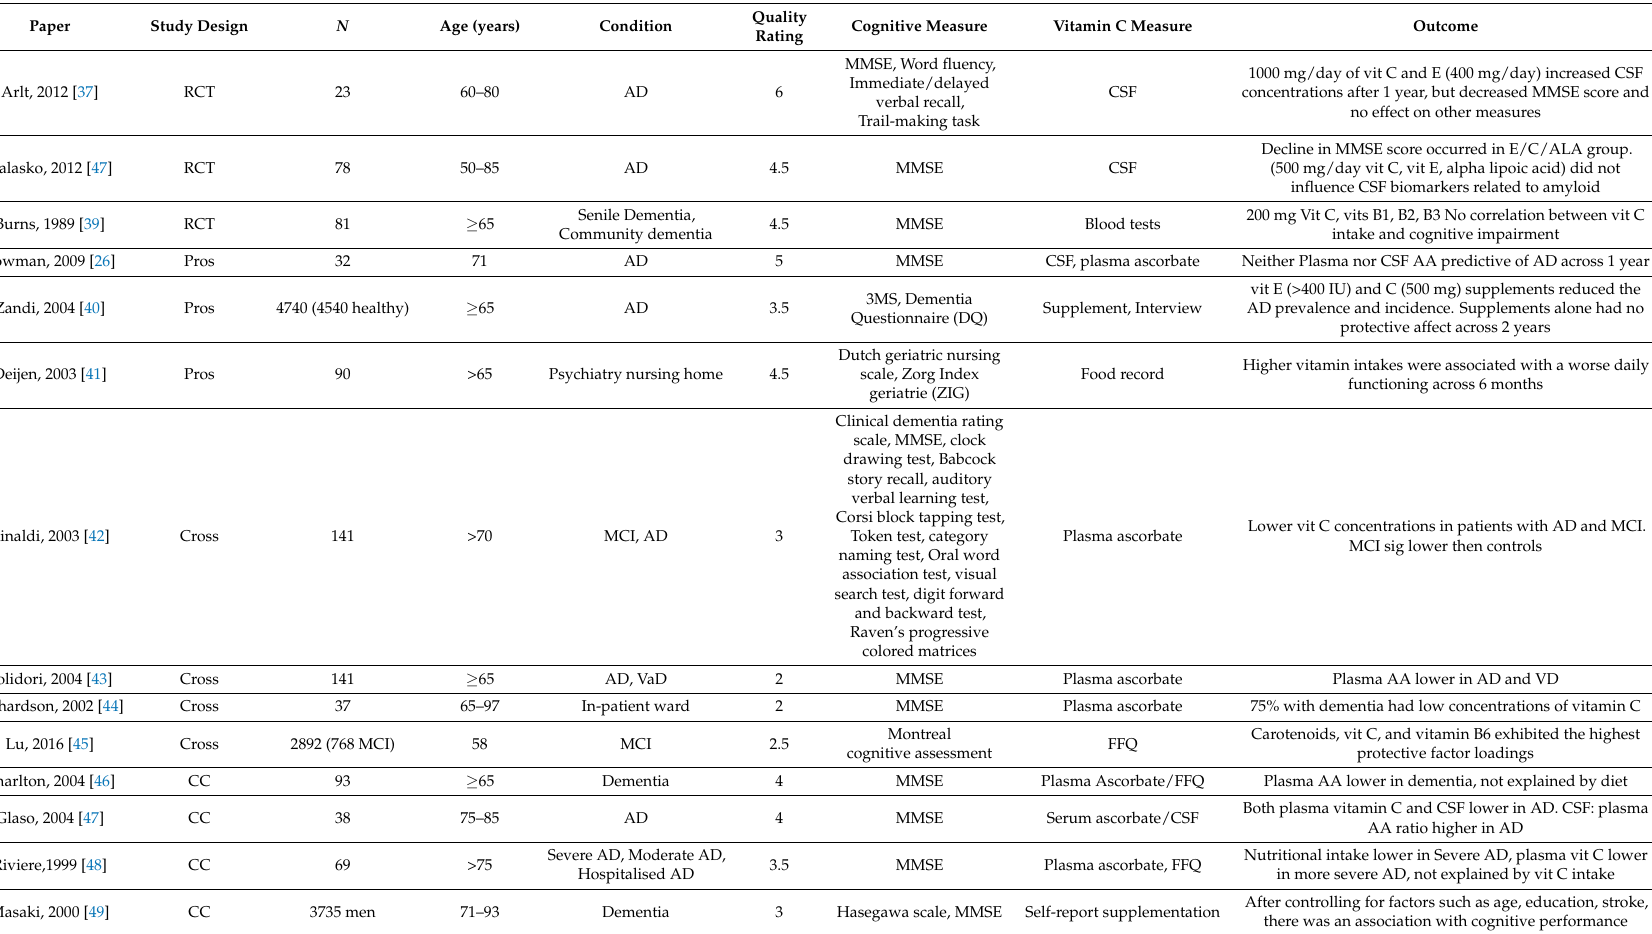
Key: MCI = Mild cognitive impairment, AD = Alzheimer’s, VaD = vascular dementia RCT = Randomized control trial, Pros = prospective, Cross = cross-sectional, CC = case-control, Vit = vitamin, FFQ = food frequency questionnaire, CSF = cerebrospinal fluid, MMSE = Mini mental state examination, 3MS = Modified Mini Mental State Examination, ALA = alpha lipoic